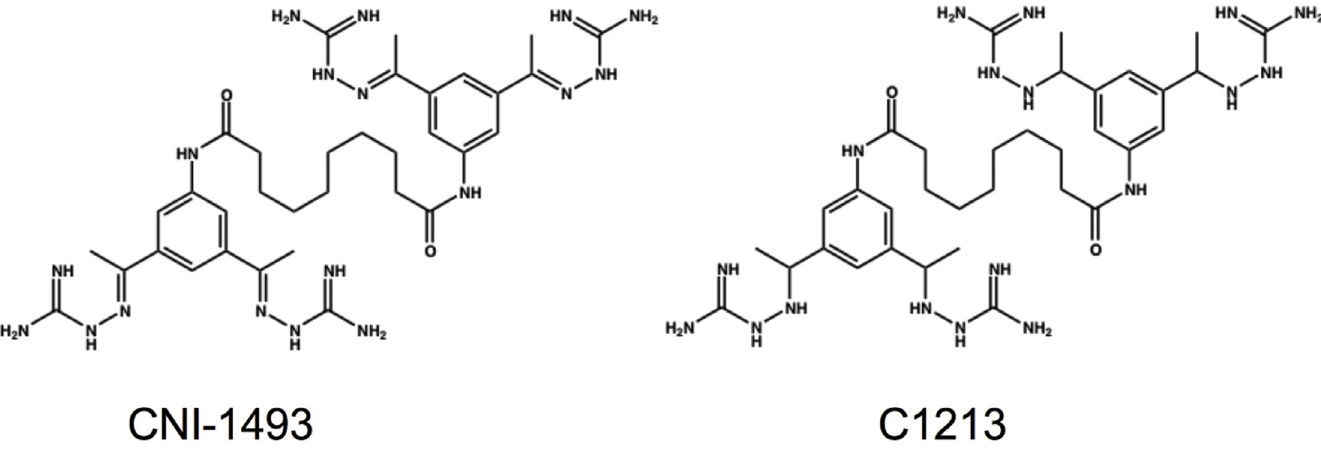
Figure 1. Molecular structures of CNI-1493 and